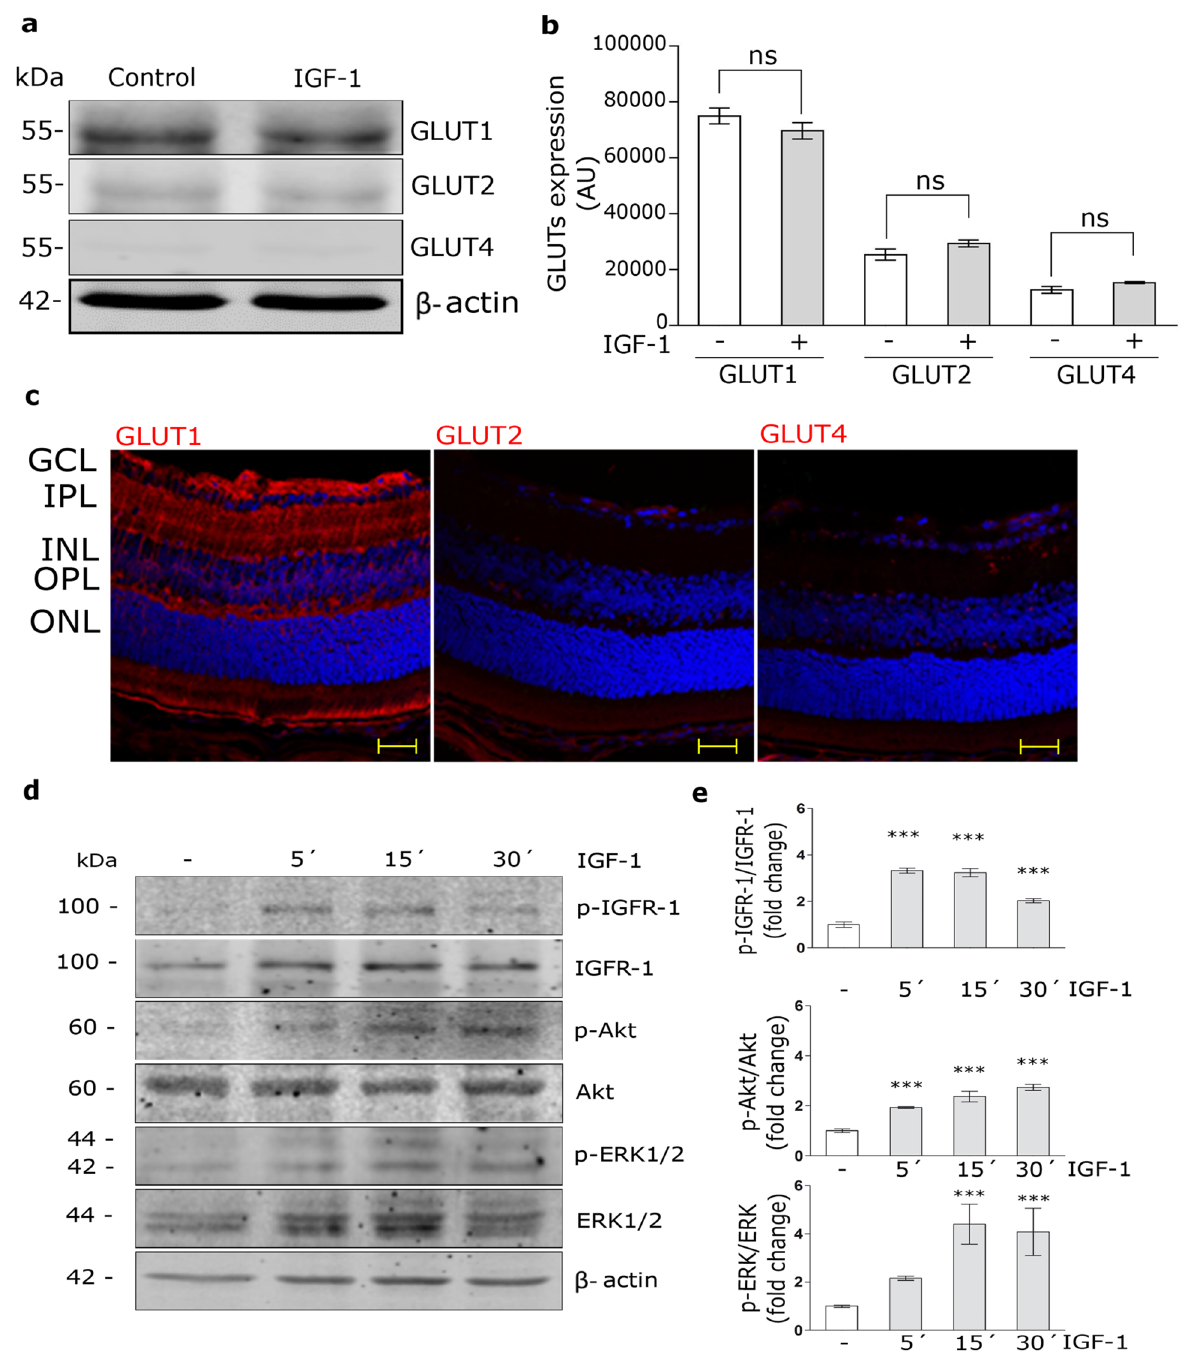
Figure 1. IGF-1 activates MAPK/ERK and PI3K/Akt pathways. ( a ) Western blot assay for the analysis of GLUT1, GLUT2 and GLUT4 expression in MIO-M1 cells treated with IGF-1 10 nM for 60 min. β-actin was used as loading control. ( b ) Densitometric quantification of Western blot data expressed as arbitrary units (AU). Values are expressed as mean ± SEM. ns = non-significant differences. Three independent experiments in duplicate were performed (n = 6). ( c ) Representative immunofluorescence analysis of GLUT1, GLUT2 and GLUT4 (red) in cryosections of mouse retinas (at 26 days of life). Abbreviations: GCL, ganglion cell layer; IPL, inner plexiform layer; INL, inner nuclear layer; OPL, outer plexiform layer; ONL, outer nuclear layer. Scale bar: 25 μm. (n = 3) ( d ) Western blot assay for the analysis of phosphorylated IGF-1R (p-IGF-1R; T1316), Akt (p-Akt; T308) and ERK 1/2 (p-ERK1/2; Thr202/Tyr204) in MIO-M1 cells treated with IGF-1 10 nM for 5–30 min. Total IGF-1R, Akt, ERK1/2 and β-actin were used as loading control. ( e ) Densitometric quantification of Western blot data expressed as fold change respect to non-stimulated control (white bar). Values are expressed as mean ± SEM. *** p < 0.001 versus non-stimulated control. Three independent experiments in duplicate were performed (n =